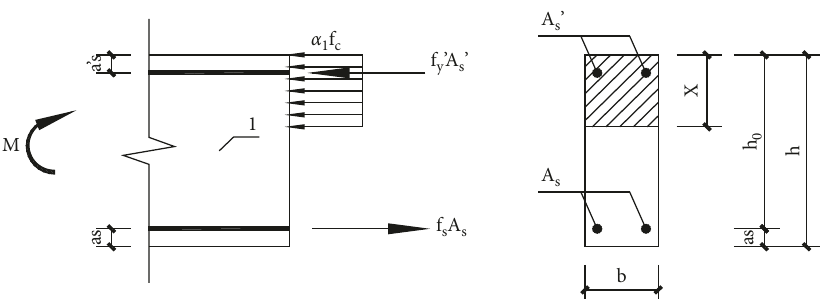
Figure 2: Calculation of flexural capacity of normal section of rectangular flexural